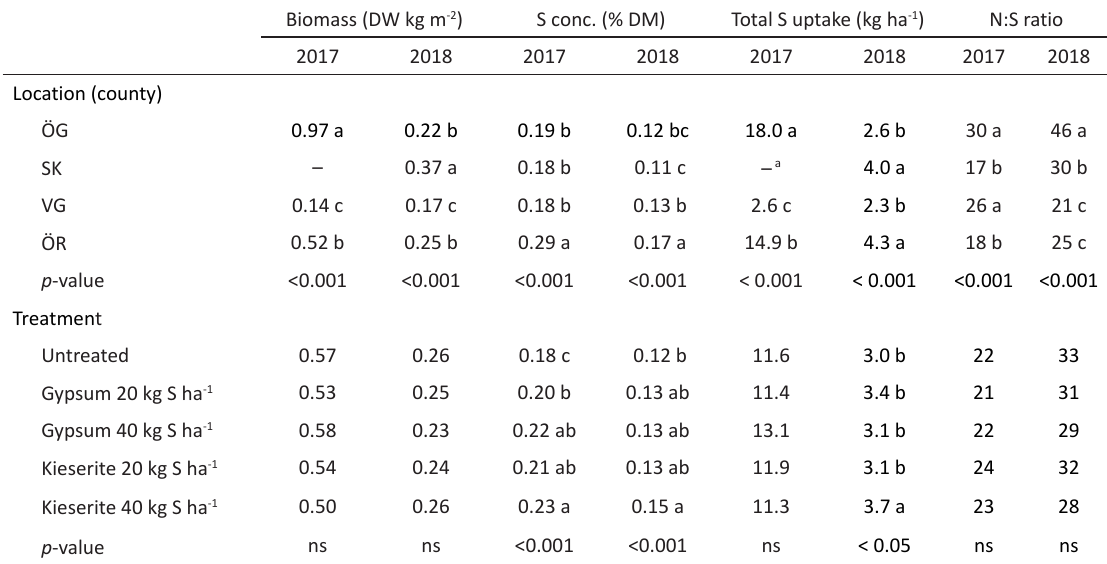
Table 3. Biomass dry matter, sulphur concentration, sulphur uptake, N:S ratio of faba bean at early flowering (BBCH 60) at the eight field locations in 2017 and 2018 with sulphur treatments Biomass (DW kg m -2